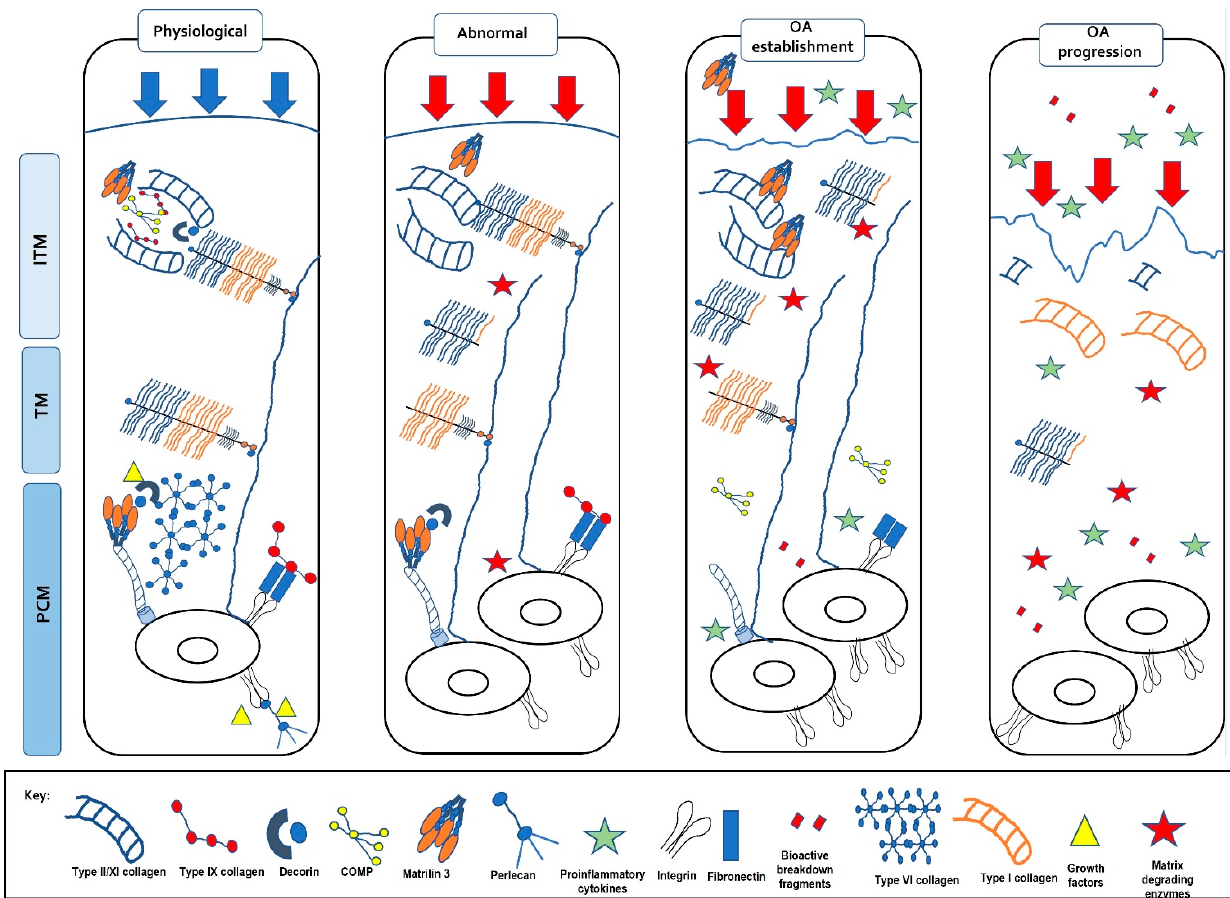
Figure 5. Changes in the extracellular matrix with load. Normal, physiological loads maintain the ECM homeostasis providing the correct biochemical composition which confers its functional properties. Abnormal, pathophysiological loads result in changes in the matrix such as proteoglycan degradation, a loss of the NC4 domain on type IX collagen, reduced type VI collagen and increased type II collagen fibril diameter. This change in matrix compromises the functional properties of the cartilage resulting in OA establishment. Matrilin-3 and COMP increase, pro-inflammatory cytokines and matrix-degrading enzymes are up-regulated, and a switch to type I collagen is observed resulting in OA progression.